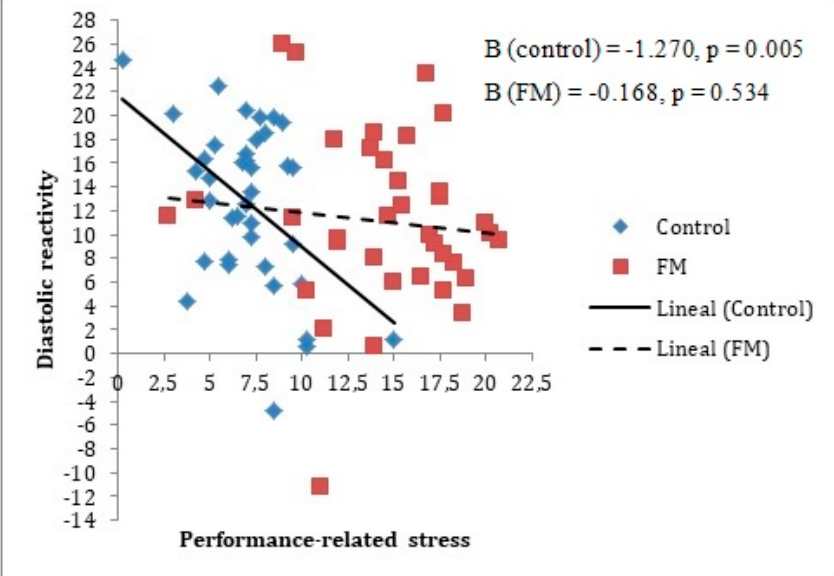
Figure 3. Group moderating role between diastolic reactivity measure and Performance-related stress factor. The reactivity index is represented as the difference between the baseline and the stress measurements (task minus baseline). In the figure, the lines represent raw scores. As can be observed, only in the control group does diastolic pressure reactivity decrease significantly when Performance-related stress factor levels increase. Note: FM = fibromyalgia; Diastolic reactivity is measured in mmHg = millimeters of mercury.